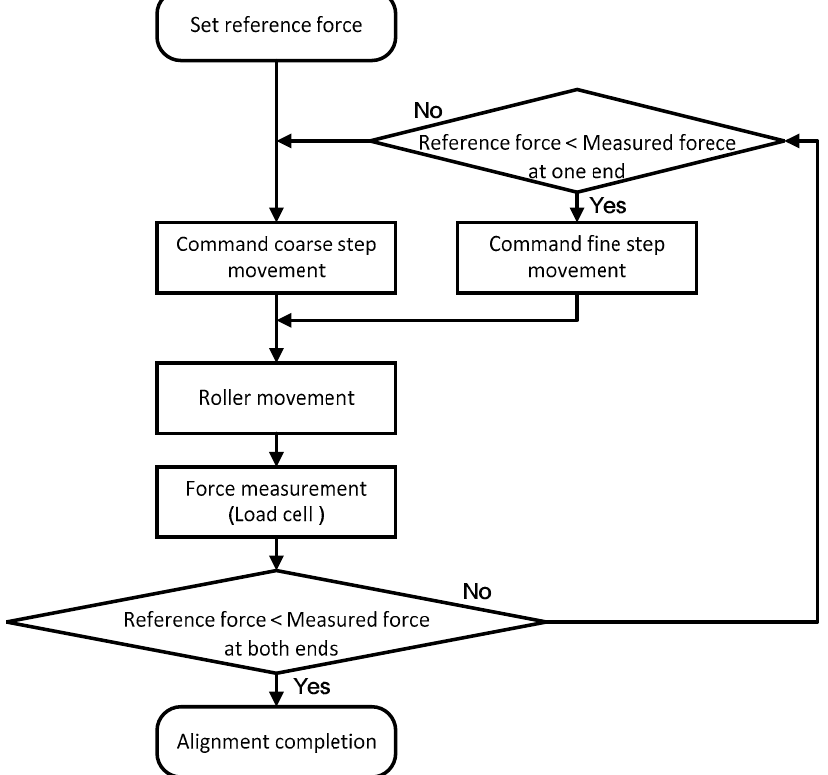
Figure 15. Flow chart for improved automatic alignment.